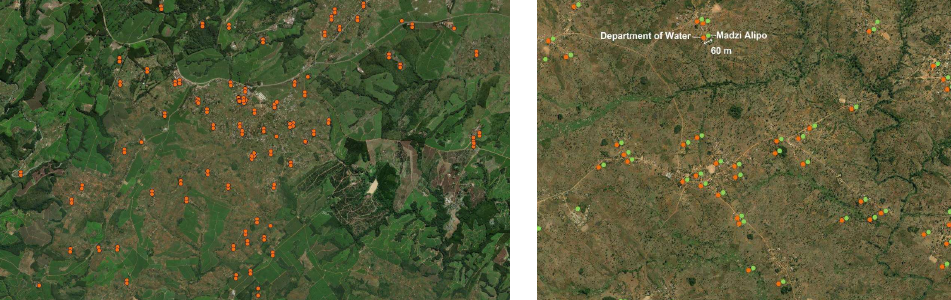
Figure 3. Duplicates in the dataset of DoIWD (left) and duplicates when comparing dataset DoIWD (red bullet) and Madzi Alipo (green bullet). Source: drone imagery Madzi Alipo.